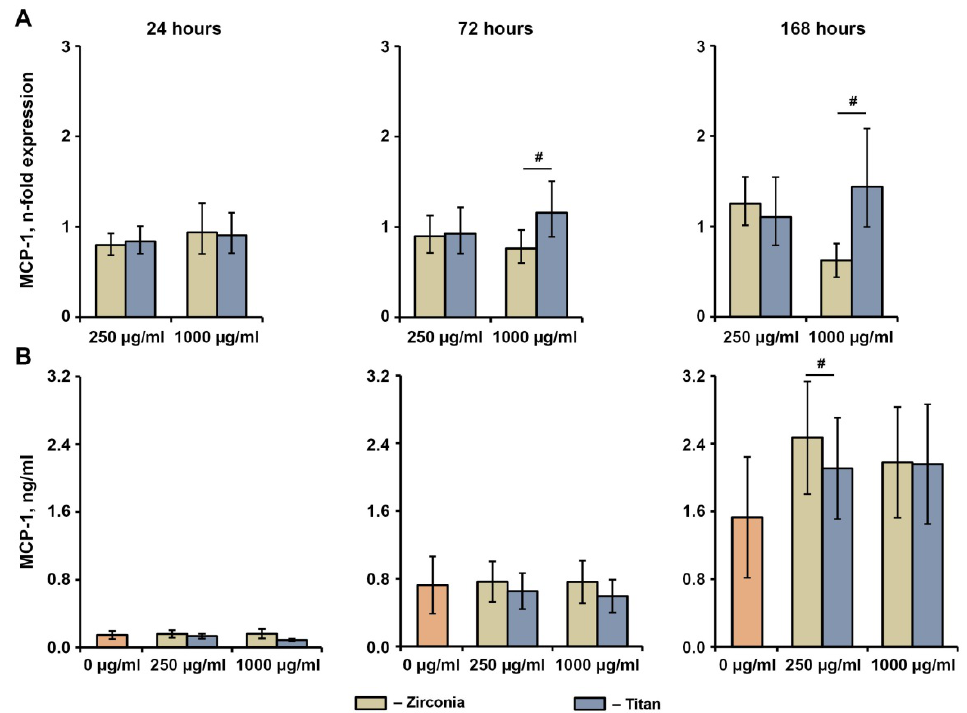
Figure 6. Effects of NPs on the basal MCP-1 expression in hG-MSCs. The hG-MSCs were cultured in the absence or in the presence of different NPs for 24 h, 72 h, or 168 h. The resulting MCP-1 gene expression ( A ) and MCP-1 protein production ( B ) rates were measured via qPCR and ELISA, respectively. ( A ) Y-axis represents n-fold expression of MCP-1 in hG-MSCs cultured with NPs compared to unstimulated control (n-fold expression = 1). N-fold expression was calculated using the 2 −ΔΔCt method, using GAPDH as the reference gene. ( B ) Y-axis shows the concentration of MCP-1 in the conditioned media Data are presented as means ± s.e.m. of six independent experiments performed with hG-MSCs isolated from six different donors. Note: #—significantly different between Ti NPs and Zr NPs, p < 0.05.